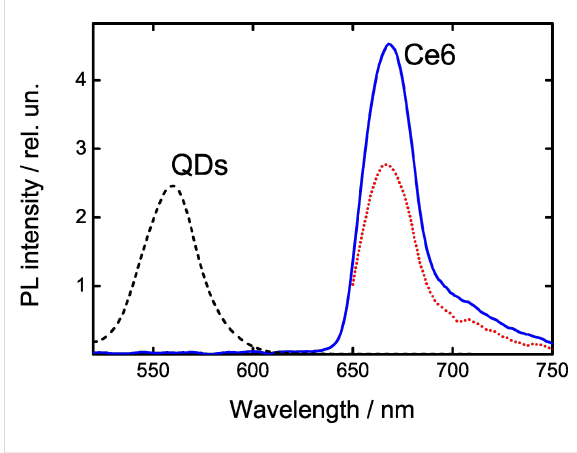
Figure 2: The absorption spectra of Ce6 (solid line), QDs (dotted line) and QD/Ce6 complexes (dashed line) in aqueous solution. The concentration of QDs: C QD ≈ 4 × 10 − 7 mol/L, n = C Ce 6 : C QD = 20. Characteristic absorption bands (Soret, Q(IV), and Q(I)) of the Ce6 are marked.